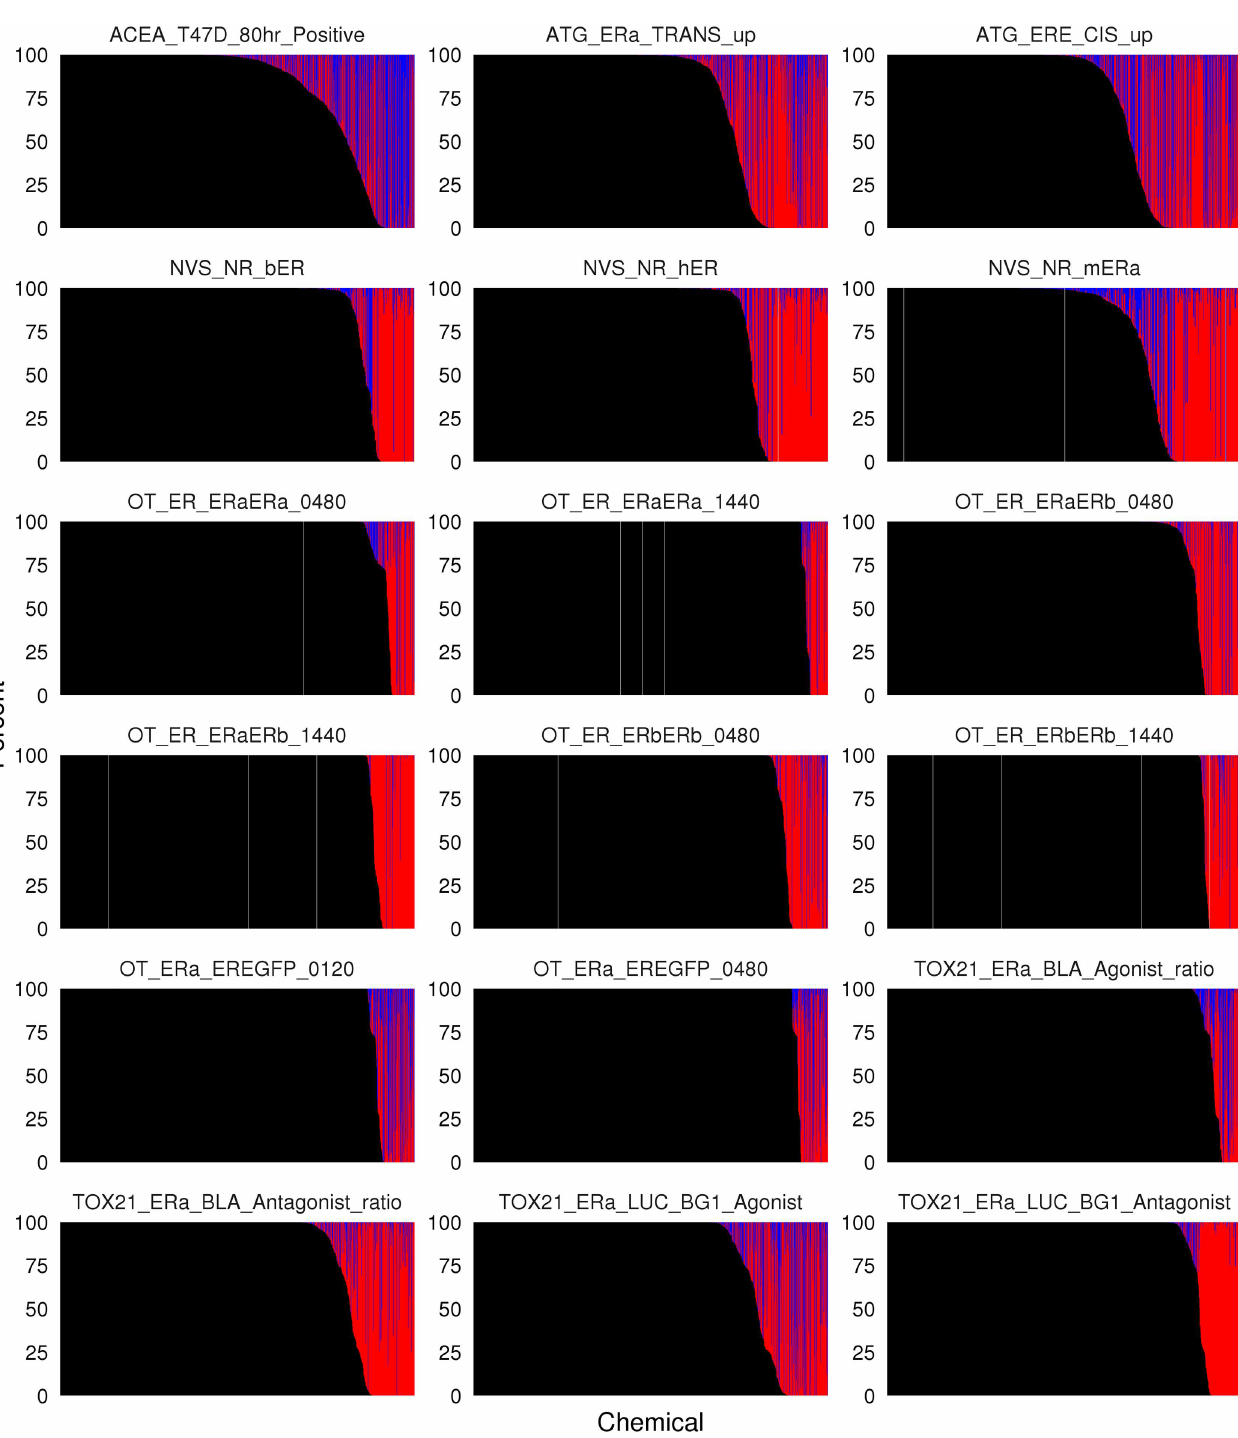
Fig 3. Model selection in hit call probability for sixteen estrogen receptor agonist assays. For each plot, chemicals are ordered on the x-axis based on their hit call probability. The y axis indicates the percent of bootstrap resamples that were calculated to be a positive hit with a hill model (red), gain loss (blue), or a negative hit